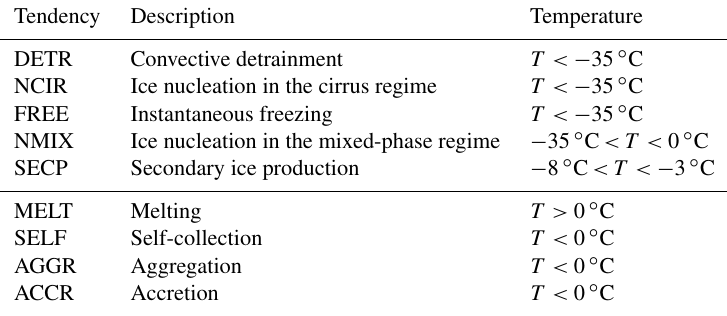
Table 1. ICNC tendencies of the microphysical processes defined in the CLOUD submodel. Sources of ICs are in the highest block, and sinks of ICs are in the lowest block. The first column contains the abbreviations associated with each tendency; the second column describes the microphysical processes associated with each tendency; and the third column specifies the temperature range in which the processes